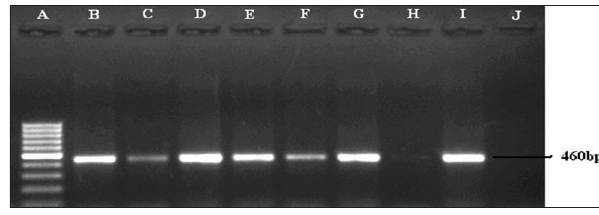
Figure-1: Pasteurella multocida species-specific polymerase chain reaction for the detection of KMT1 gene (460 bp) of P. multocida. Lane A: 100 bp DNA Ladder. Lane B to H: Samples positive for kmt gene. Lane J: Negative control.